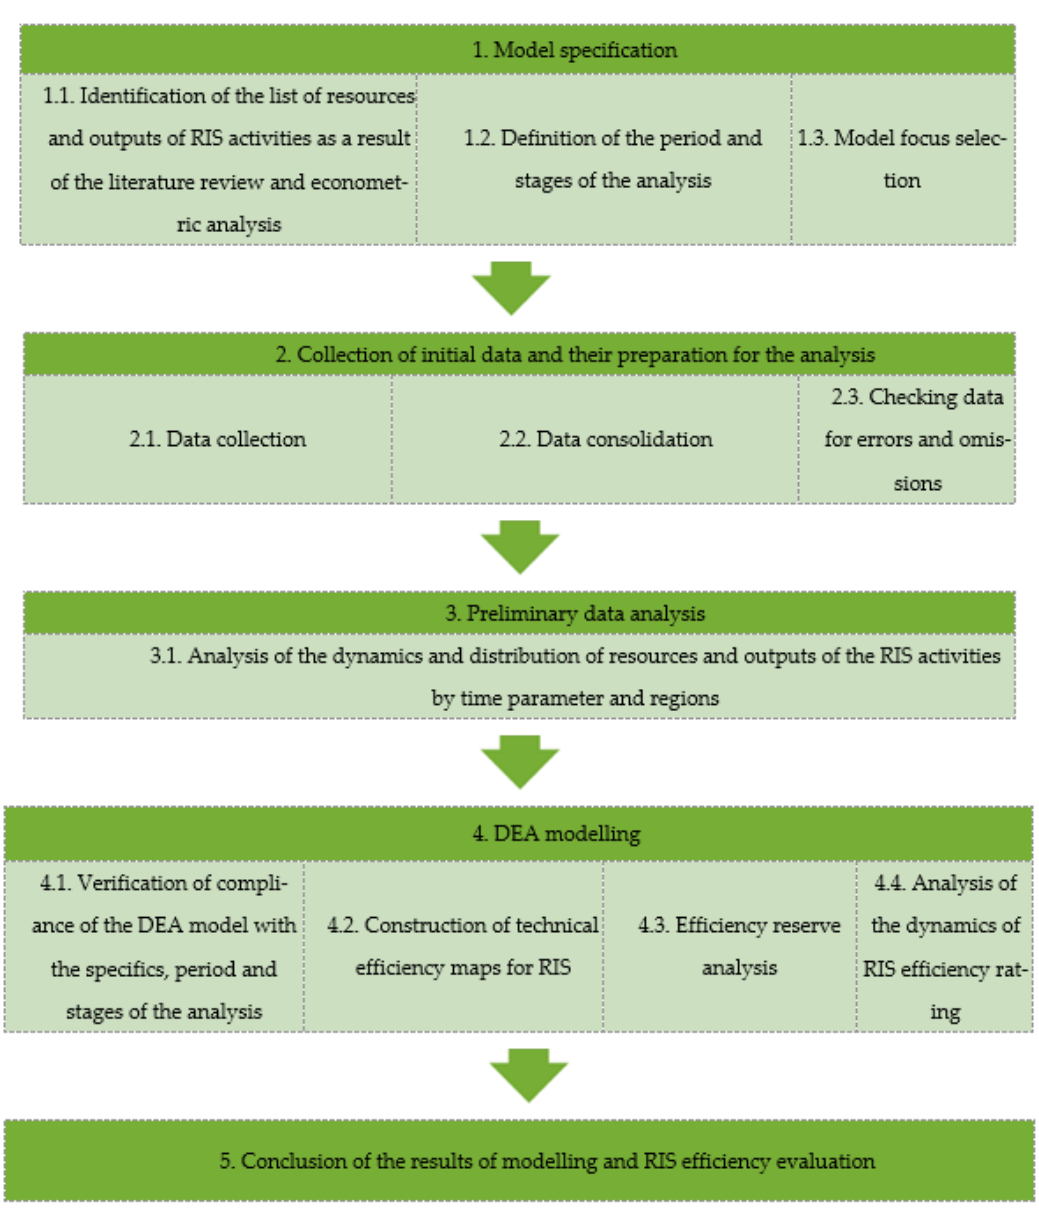
Figure 1. DEA modelling algorithm (compiled by the author based on [78–82]).